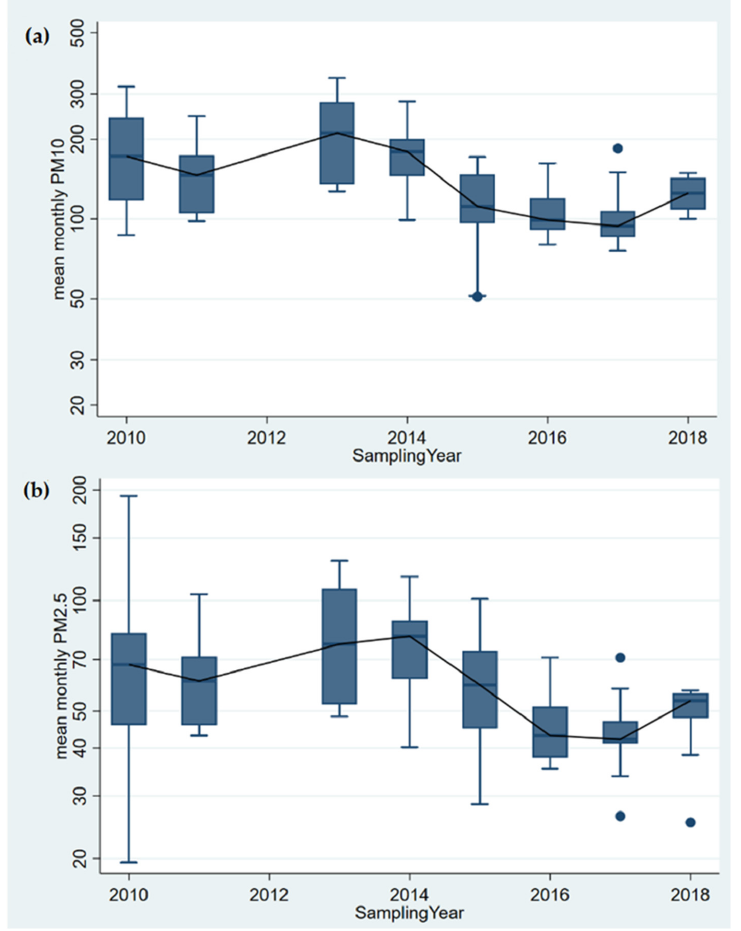
Figure 3. PM mass concentration monitored at “Auber” station of the Parisian subway network (using TEOM device): ( a ) PM 10 mass concentration. ( b ) PM 2.5 mass concentration.